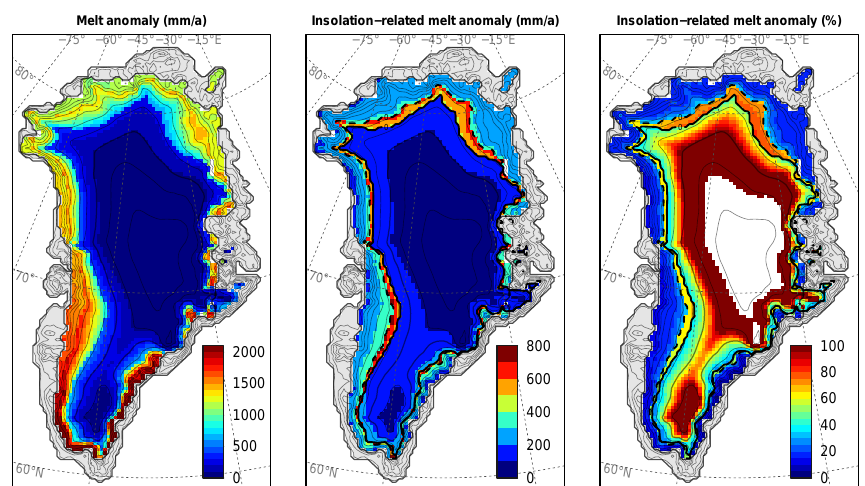
Figure 2. Melt anomaly at 126kaBP, given a 3 ◦ C summer temperature anomaly relative to today. Left: total melt anomaly (mma − 1 ). Center: melt anomaly (mma − 1 ) due to insolation changes. Right: percentage of melt due to insolation changes. In the center and right panels, the solid and dashed black lines show the equilibrium line altitude for the full ( M(S) ) and reduced model ( M(S 0 ) ), respectively.